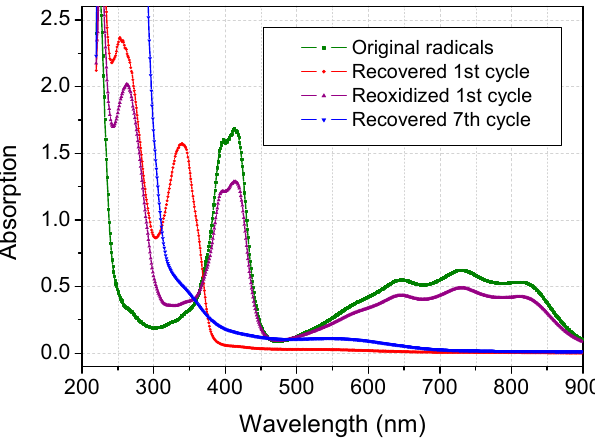
Figure 4. Variation of UV-Vis spectra of recovered ABTS and its radicals.